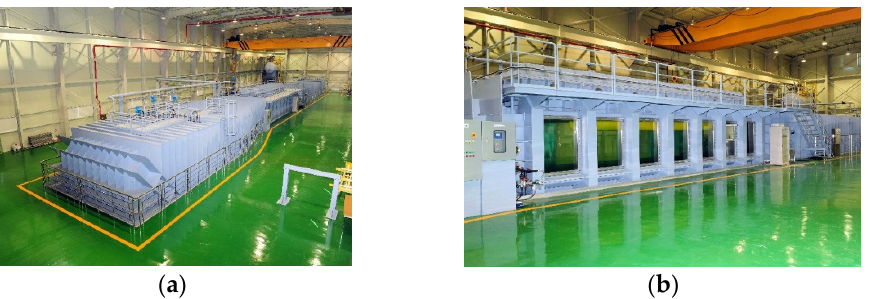
Figure 3. Photos of large cavitation tunnel (LCT) in KRISO. ( a ) Isometric view of the tunnel, ( b ) test section of the tunnel.